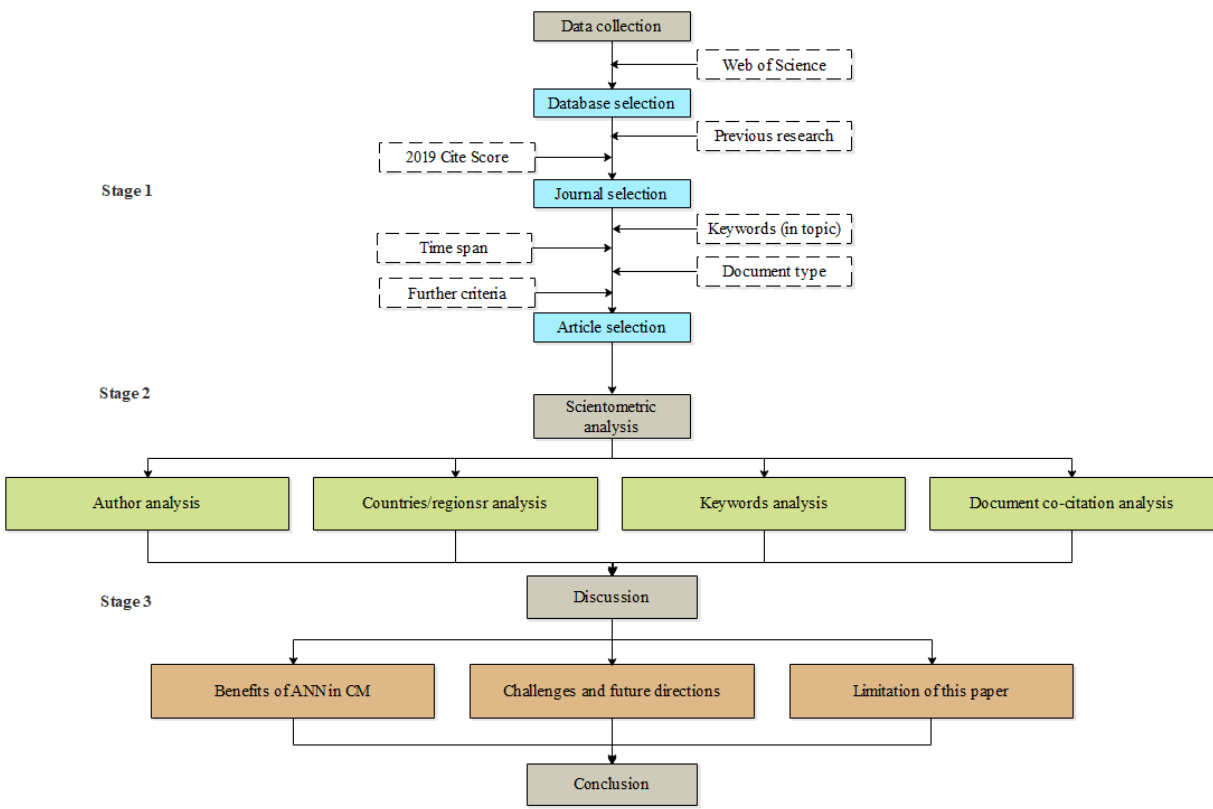
Figure 1. Outline of research methodology.